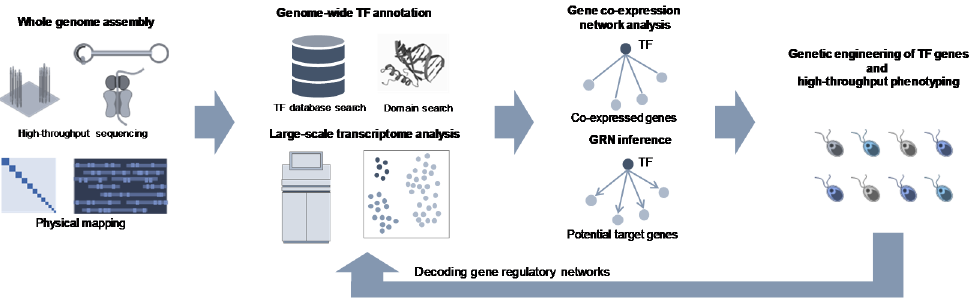
Figure 1. A schematic representation of transcription factor-based metabolic engineering in microalga species.